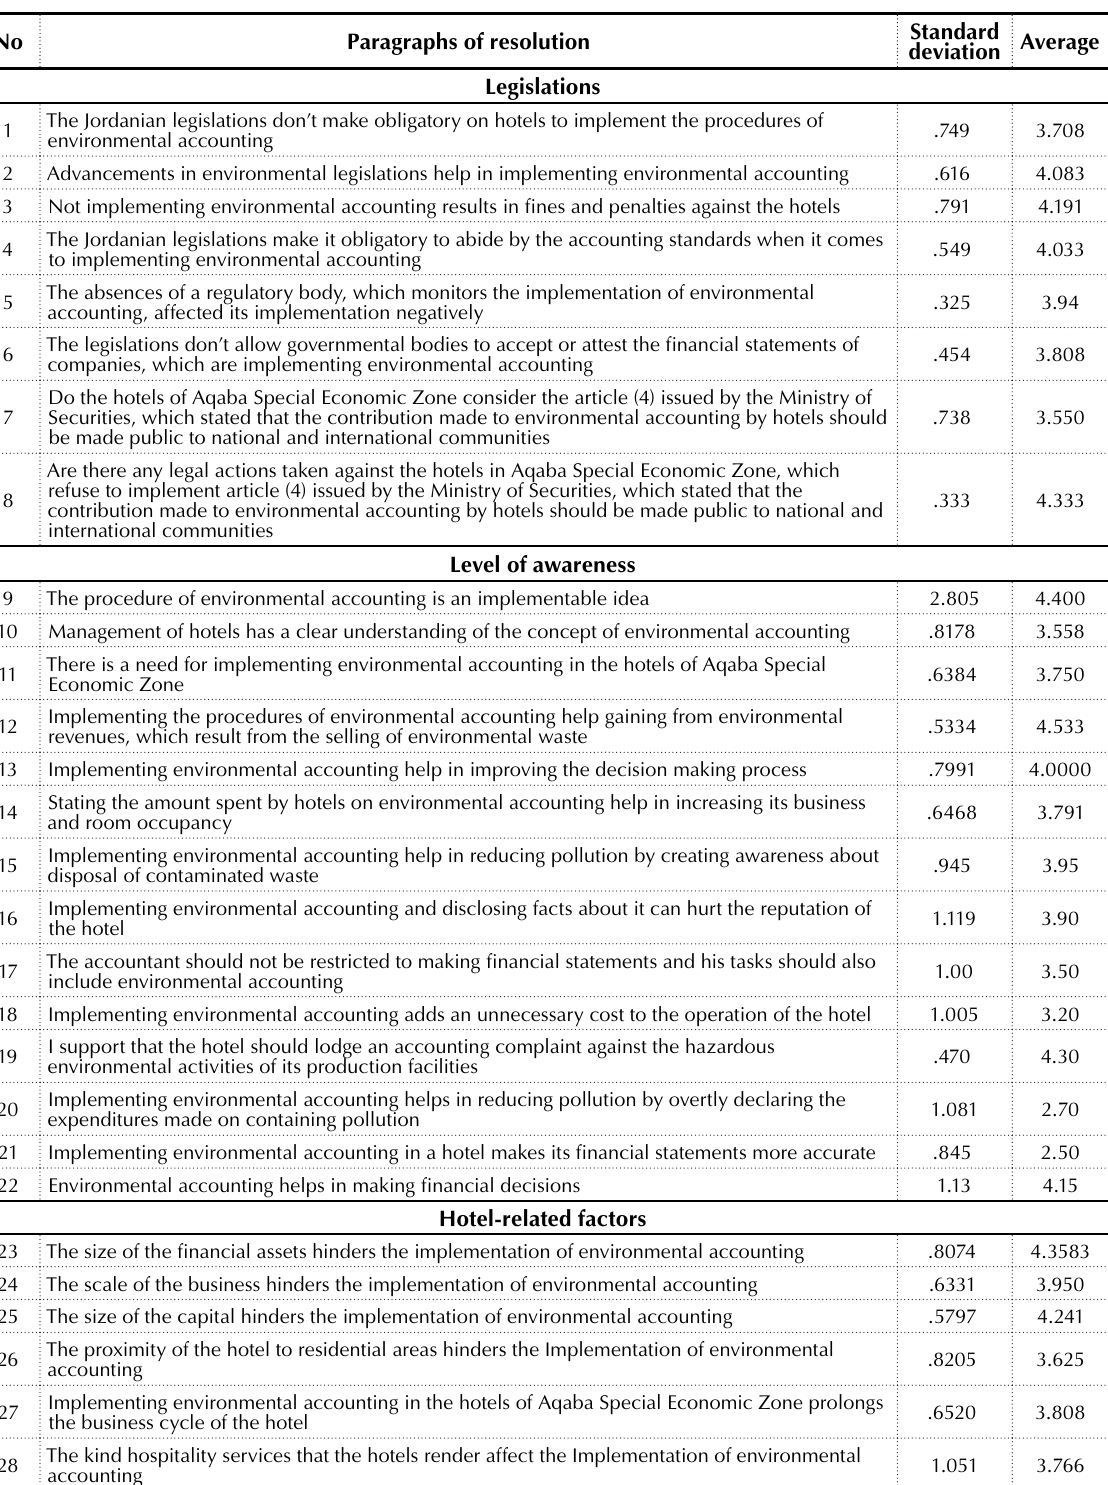
Table 11. The mean and the standard